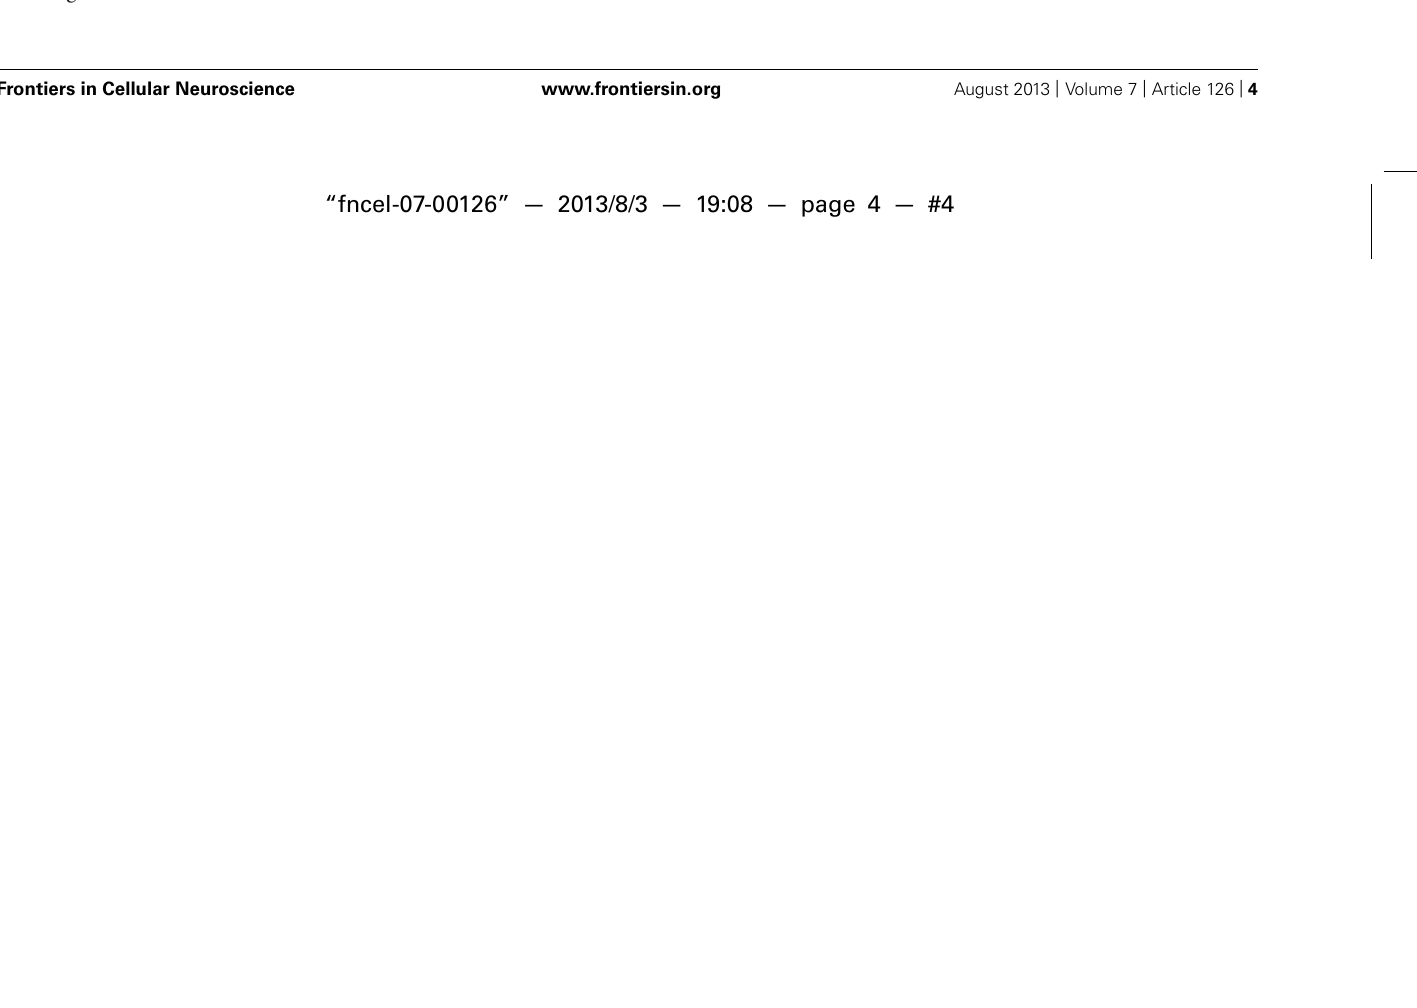
FIGURE 2 | Model for miRNA-mediated regulation of neuronal function. In the neuron, protein synthesis occurs in multiple compartments that include the cell body, dendrite, axon, and presynaptic nerve terminal. A subset of mRNAs transcribed in the nucleus are packaged into stable messenger ribonucleoproteins complexes (mRNPs) and are selectively and rapidly transported to the distal structural/functional domains of the neuron.The selective translation of these localized mRNAs plays key roles in neuronal development, axon growth and maintenance, and synaptic plasticity. Neuronal miRNAs function at multiple levels within the neuronal gene expression system to modulate neuronal activity and function. It has been shown that miRNAs regulate the local post-transcriptional gene